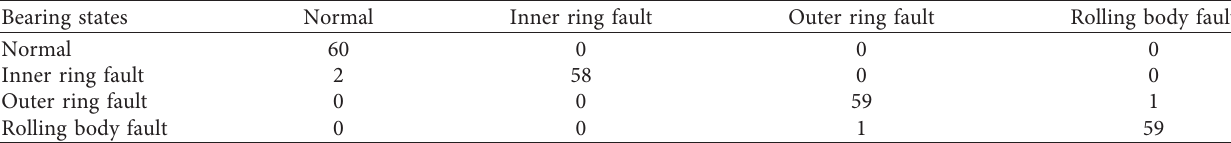
Table 3: Confusion matrix of test results with learning rate �